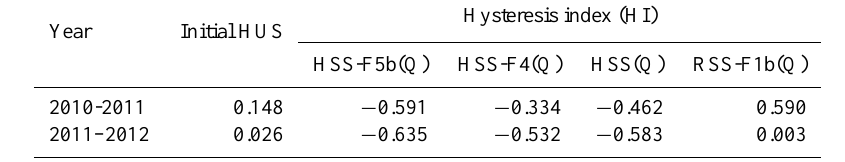
Table 5. Hysteresis indexes (HIs) and initial hillslope unsaturated-storage values (HUS) at the beginning of the water year.